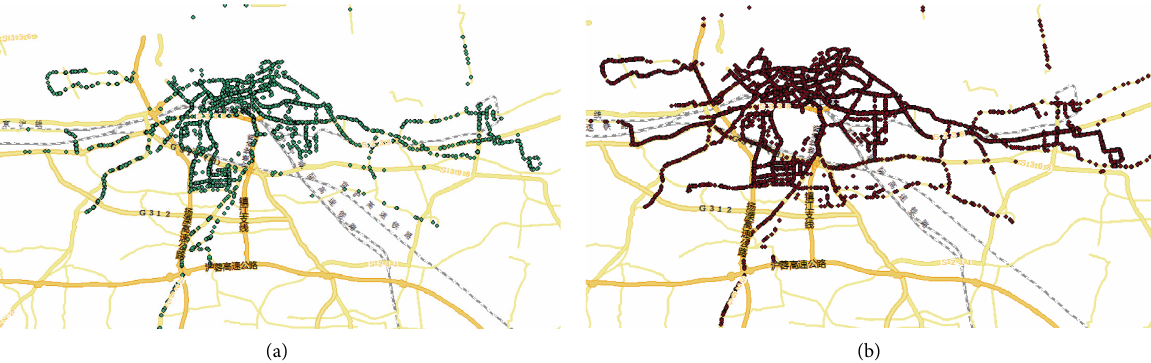
Figure 6: Spatial distribution of forewarnings: (a) location of driver fatigue forewarning; (b) location of vehicle abnormal state forewarning.